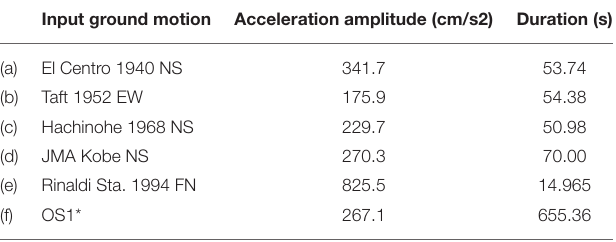
TABLE 2 | Acceleration amplitude of input recorded ground